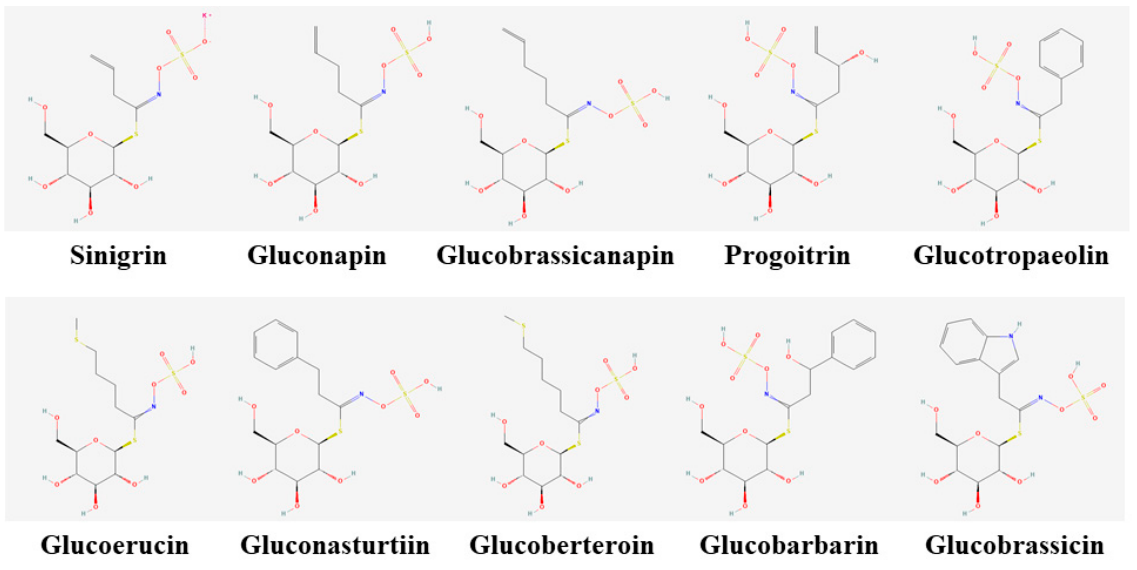
Figure 1. Chemical structures of ten glucosinolates were analyzed in this experiment.